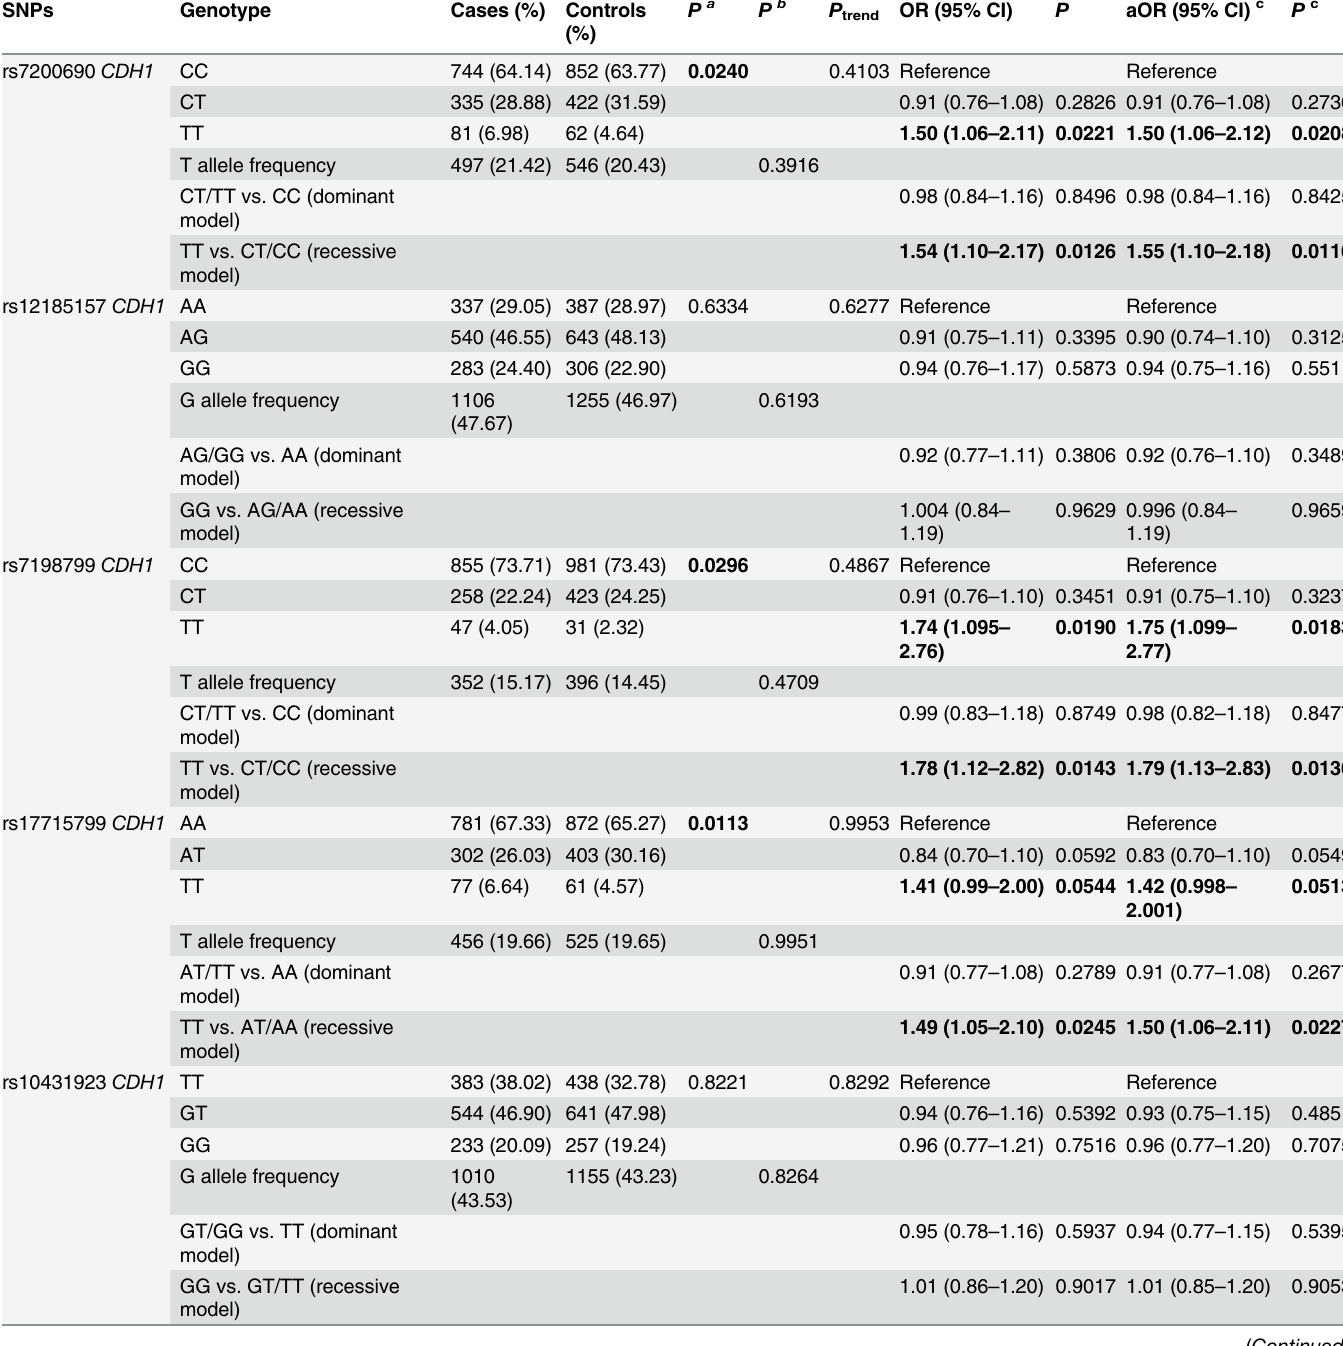
Table 1. Genotype and allele frequencies of the selected SNPs in CDH1 and CTNNB1 and their associations with risk of breast